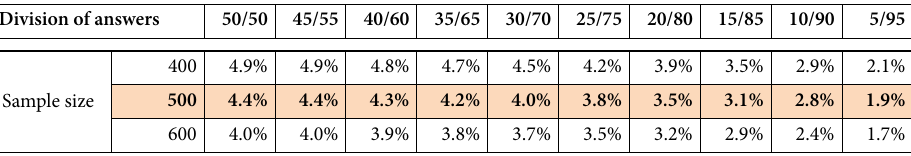
Fig. 4. Possible statistical error of survey answers (Source: JSC ”Eurotela“ and authorial computation)